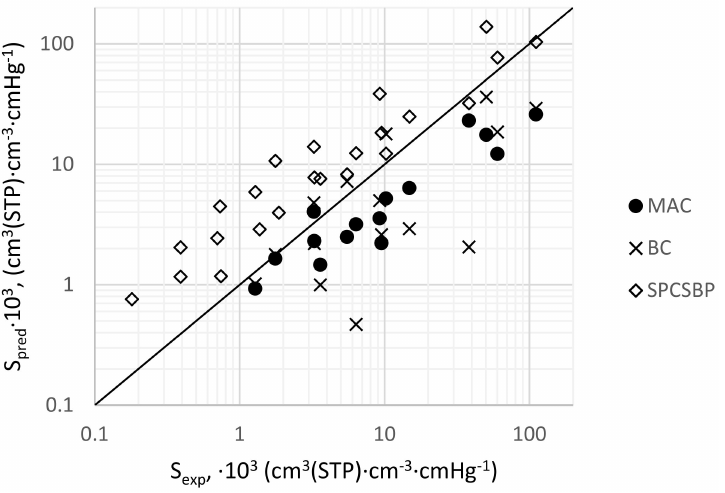
Figure 8. Comparison diagram of predicted and experimental values of solubility